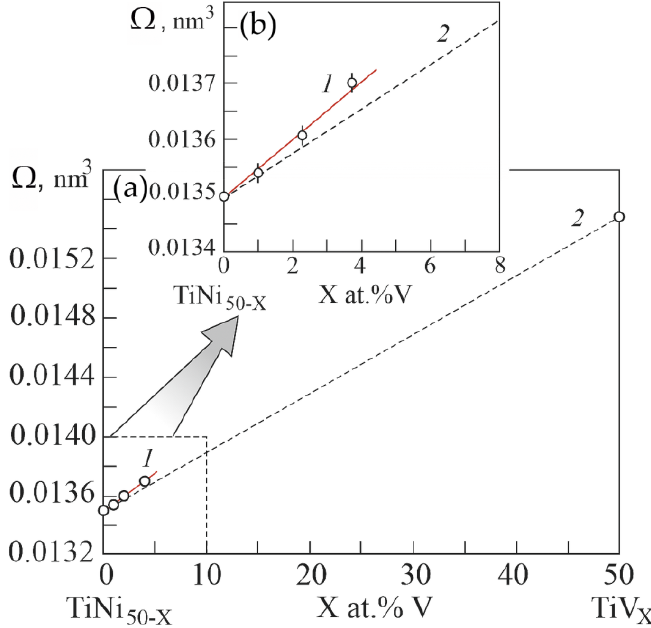
Figure 10. Concentration dependence of atomic volumes in the ternary system Ti 50 Ni 50 − X V X ( a ). Curve 1 was obtained from the data from the experiment of the concentration dependence of lattice parameters in the Ti 50 Ni 50 − X V X system. Curve 2 is theoretical dependence, calculated according to Zen’s law. Inset ( b ) shows an enlarged scale of the concentration dependence of atomic volumes in the region of low concentrations V.